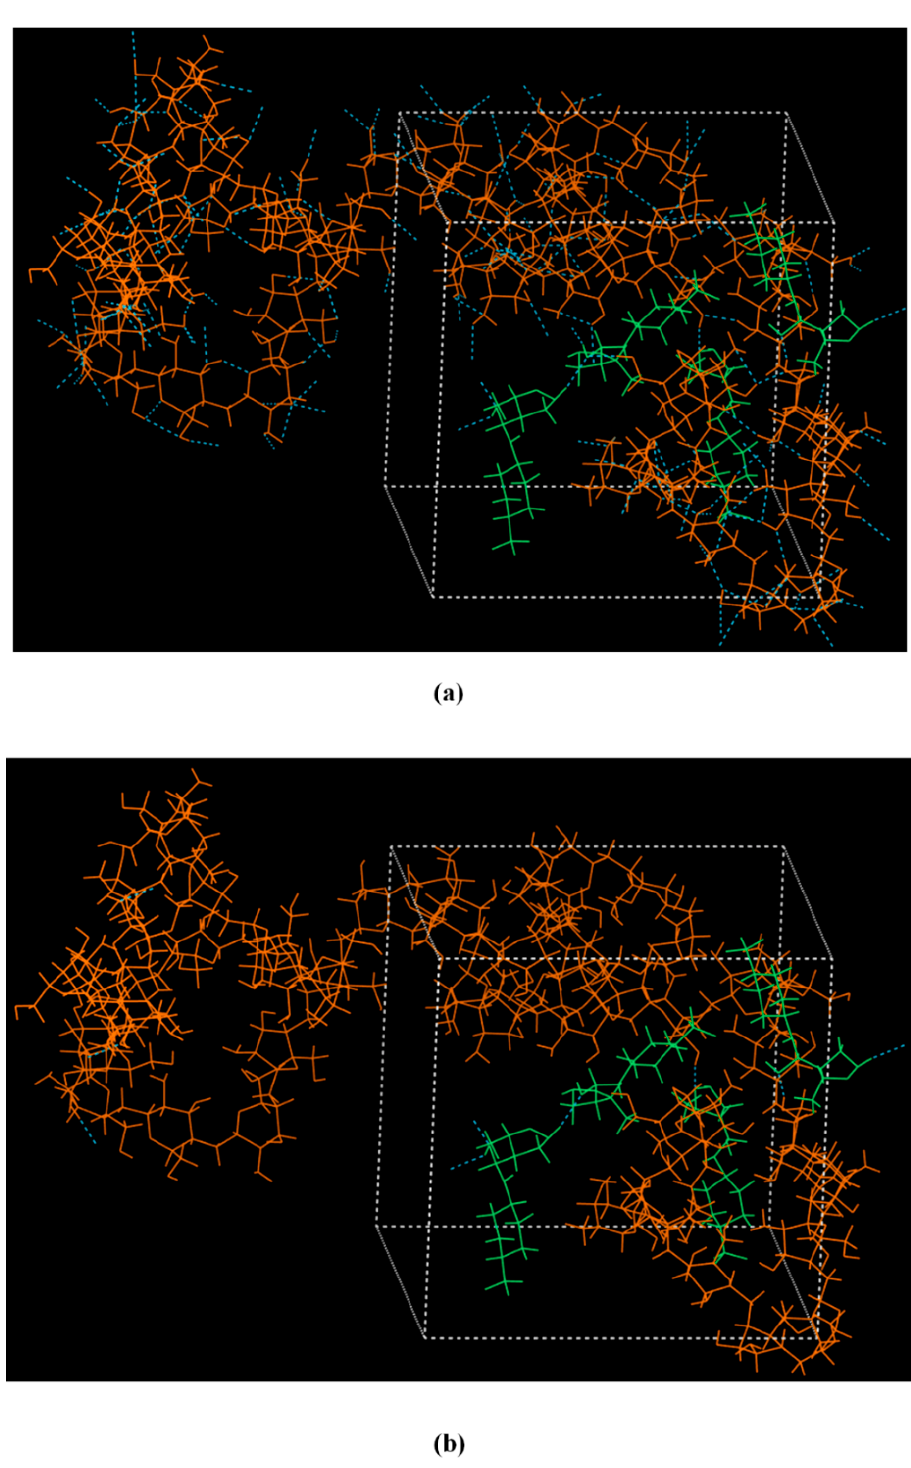
Figure 4. ( a ) Amorphous CS-LFD structures showing: ( a ) the formation of HBs among the neat CS molecules, and ( b ) the formation of HBs between the CS and LFD molecules (CS is depicted with orange and LFD with green).